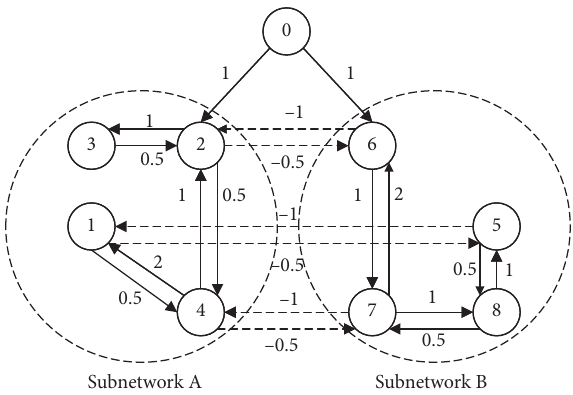
Figure 3: The directed signed graph. Table 1: The physical parameters of the eight robotic